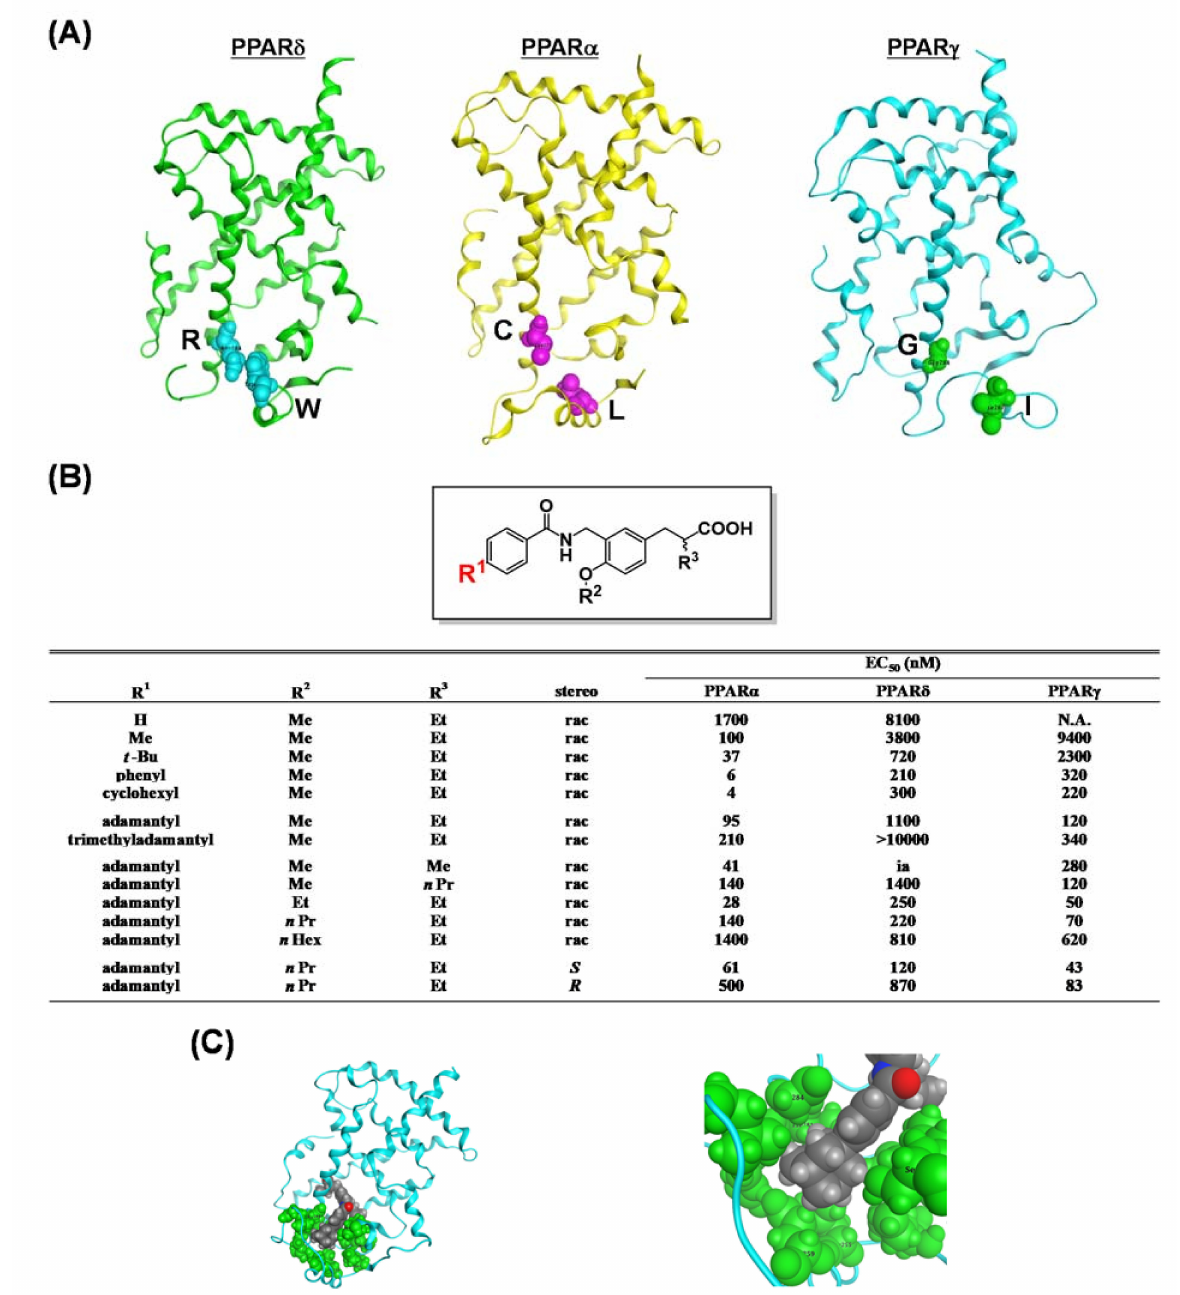
Figure 13. ( A ) Crystal structures of hPPAR δ , hPPAR α and hPPAR γ LBDs. ( B ) PPAR agonist activities of a series of compounds. ( C ) (left) Structure of the whole hPPAR γ LBD–TIPP-703 complex. (right) Zoomed view of the amino acids that interact with the hydrophobic tail of TIPP-703 complexed with the hPPAR γ LBD. The side chain amino acids and the ligand are depicted with space-filling